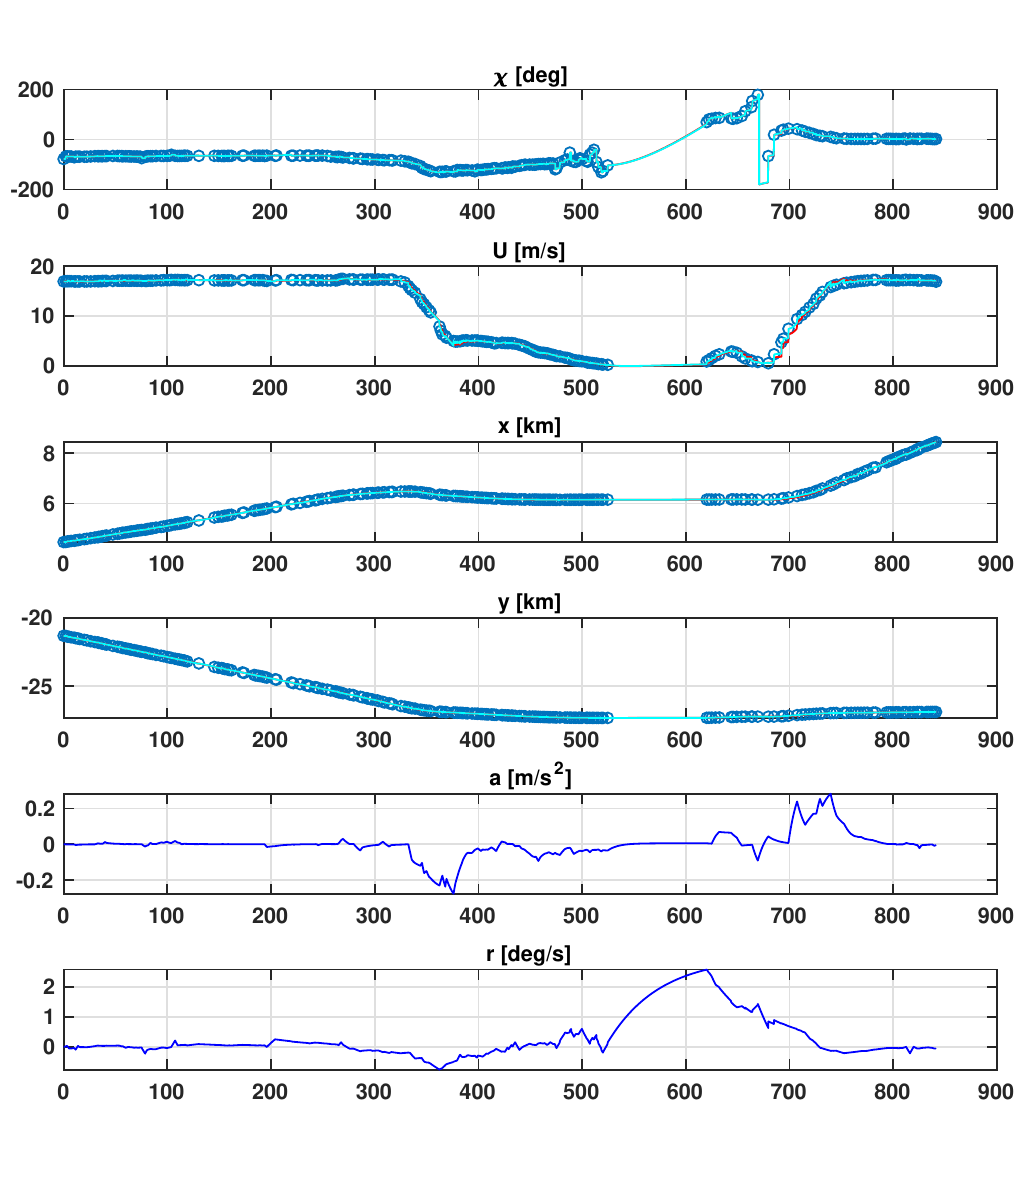
Figure 10: Course angle χ [deg], speed U [m/s], x -position [km], y -position [km], acceleration a [m/s 2 ] and yaw rate r [deg/s] versus time s. The circle denotes the live AIS measurements, while the red and cyan lines are the kinematic observer and XKF estimates, respectively. The period of inactivity corresponds to the stop in Lensvik